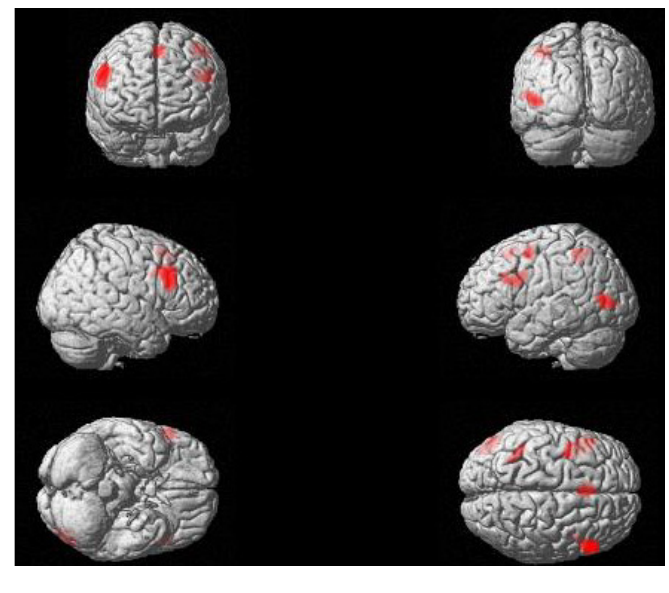
Figure 1. Regions of differential activation for passive as compared to active sentences (voxel-wise threshold of p < 0.001; k ≥